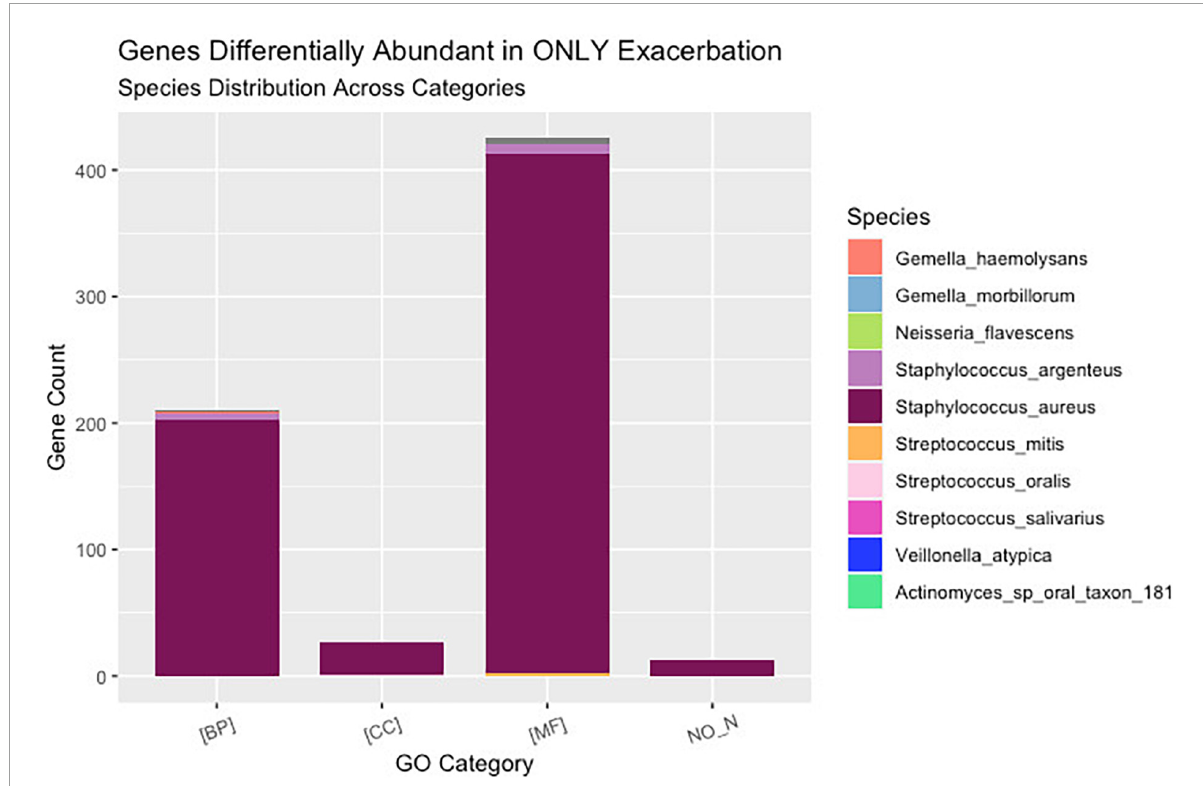
FIGURE6 Uniquely differentially abundant genes at pulmonary exacerbation versus end of treatment. While ten bacterial species were identified to have a differential abundance of bacterial genes across clinical states (i.e., pulmonary exacerbation, end of treatment, and follow-up), the majority of bacterial genes differentially abundant in exacerbation belonged to Staphylococcus aureus . GO, gene ontology; BP, biological processes; MF, molecular functions; CC, cellular